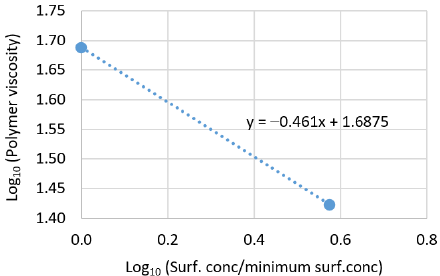
Figure 3. Influence of polymer concentration on polymer solution viscosity.